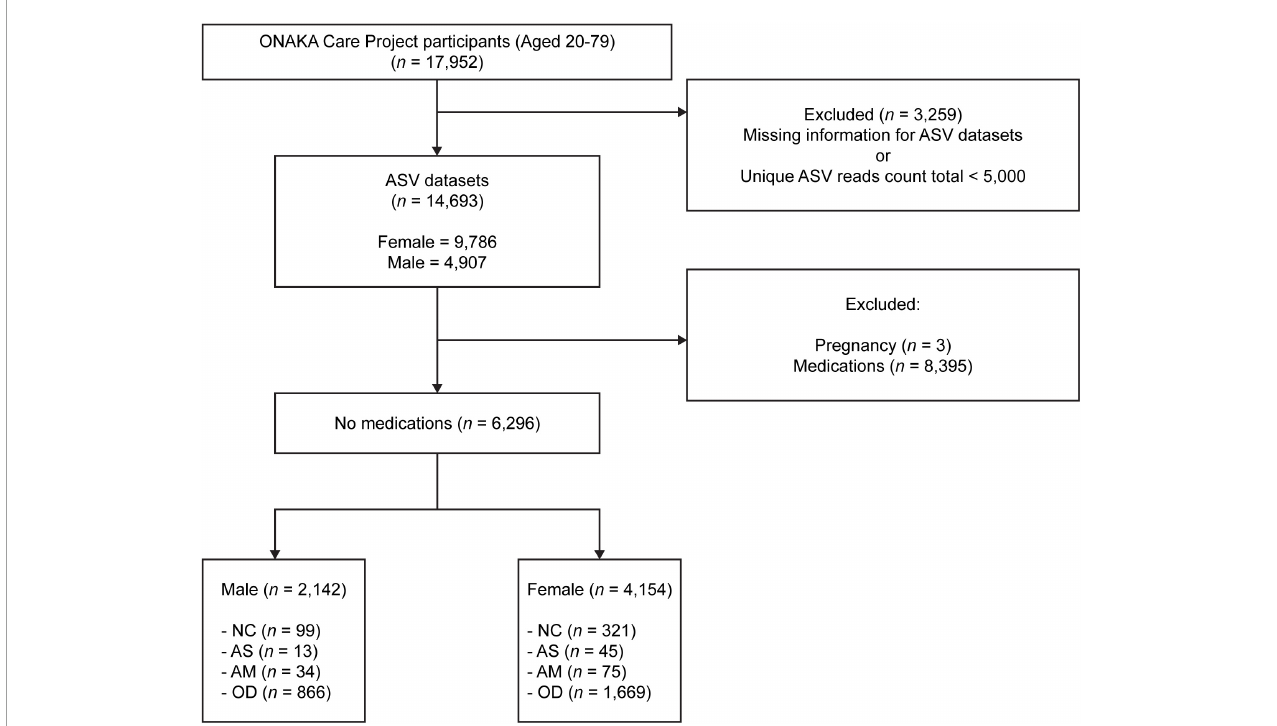
FIGURE1 Flowchart showing the target groups analyzed in this study. There were a total 17,952 samples, each from a different Japanese participant aged 20–79 years, which were collected through the ONAKA Care Project. The amplicon sequence variant (ASV) data was obtained using 14,693 of the 17,952 samples. NC, normal controls; AS, patients with atopic dermatitis without other diseases; AM, patients with atopic dermatitis with other diseases; OD, patients with other diseases but without atopic dermatitis. Please refer to the (Section “2. Materials and methods”) subsections (Section “2.7.1. Normal control group”, “2.7.2. Patients with atopic dermatitis and no other diseases”, “2.7.3. Patients with atopic dermatitis and other diseases”, and “2.7.4. Patients without atopic dermatitis but with other diseases”) for details on the criteria used to define each